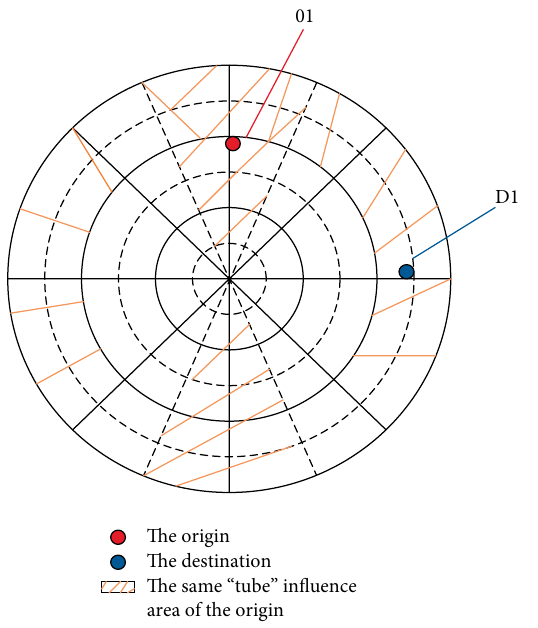
Figure 3: Illustration of the origin and destination of a